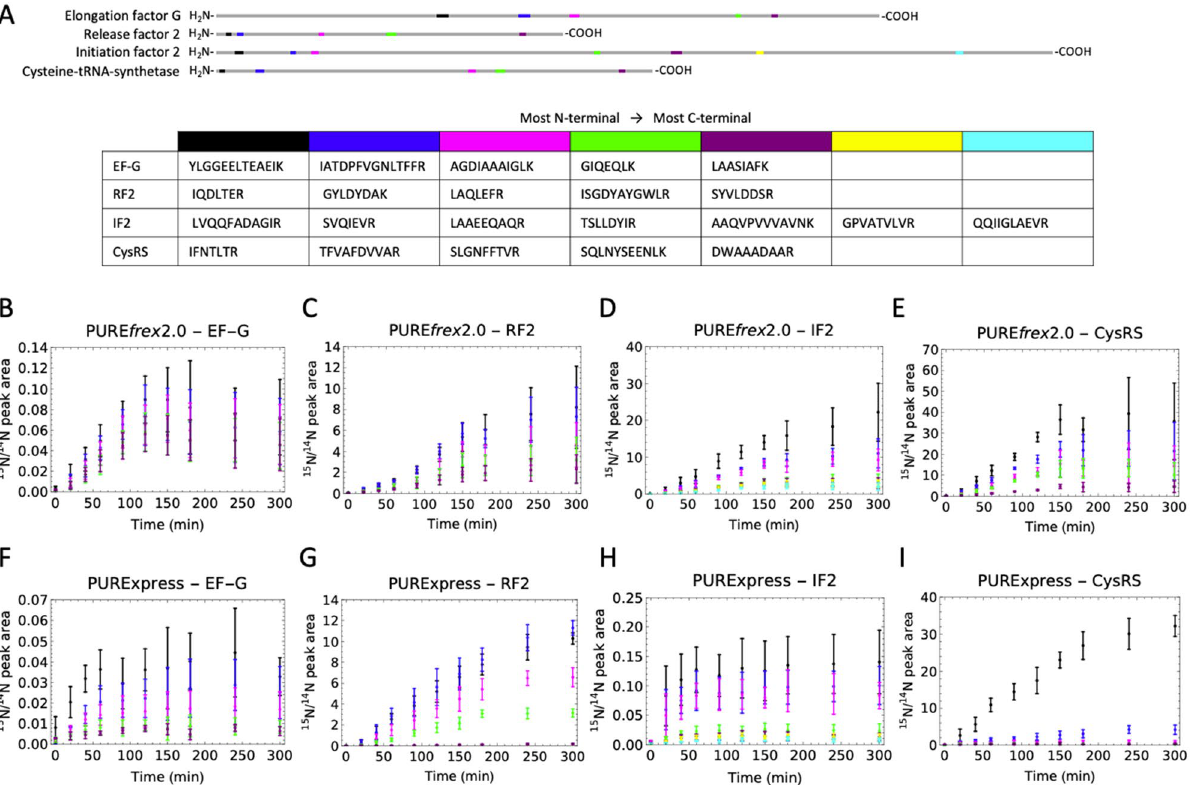
Figure 3. Time-course of 15 N-to- 14 N ratio of selected peptides for four proteins encoded in pTFM1. ( A ) Schematic of the full-length proteins displaying the positions of selected proteolytic peptides. For each cell-free synthesized protein, the set of signature peptides is chosen to span the entire polypeptide chain from the N- to C-termini. Color coding from N- to C-terminal peptides: black, blue, pink, green, magenta, yellow, cyan. The set of specific peptides measured for all four proteins is also indicated. EF-G elongation factor G, RF2 release factor 2, IF2 initiation factor 2, CysRS cysteine-tRNA-ligase. ( B–I ) Relative expression levels of the indicated peptides for the four annotated proteins with PURE frex 2.0 ( B–E ) and with PURExpress ( F–I ). Color coding of the peptides is similar as in ( A ). The five kinetics plots in ( B ) are displayed in separate graphs in Supplementary Fig. 3. All reactions were performed at 37 °C. Error bars denote ± 1 standard deviation from triplicate